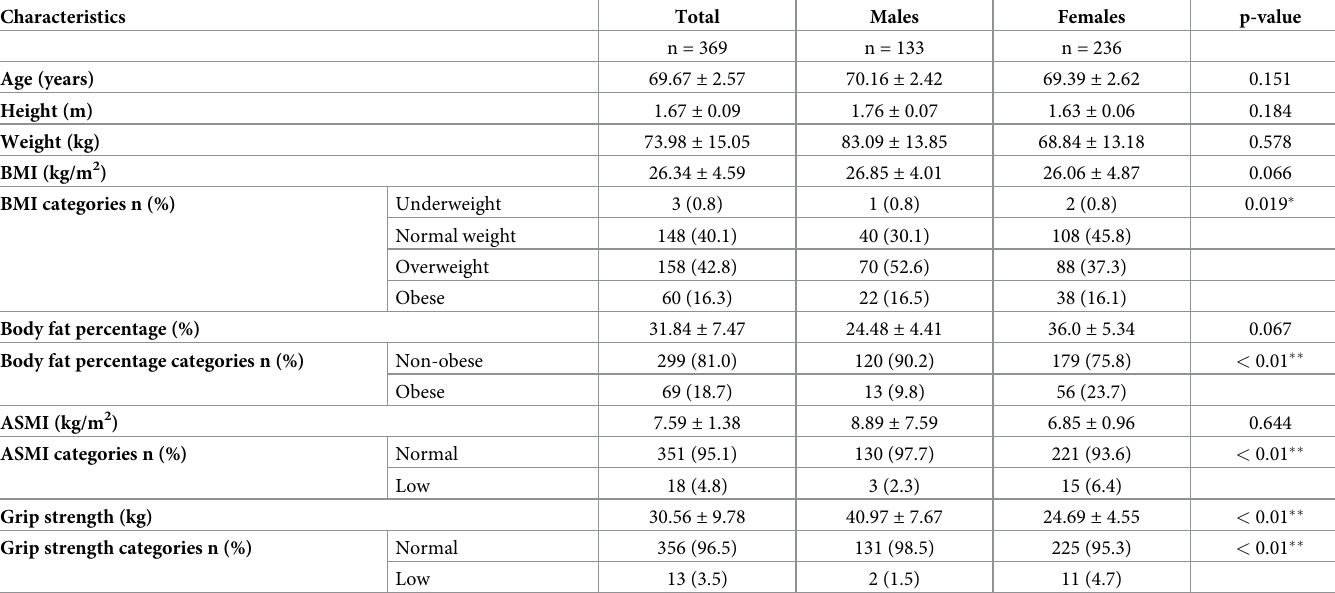
Table 1. Characteristics of study participants by sex a,b .